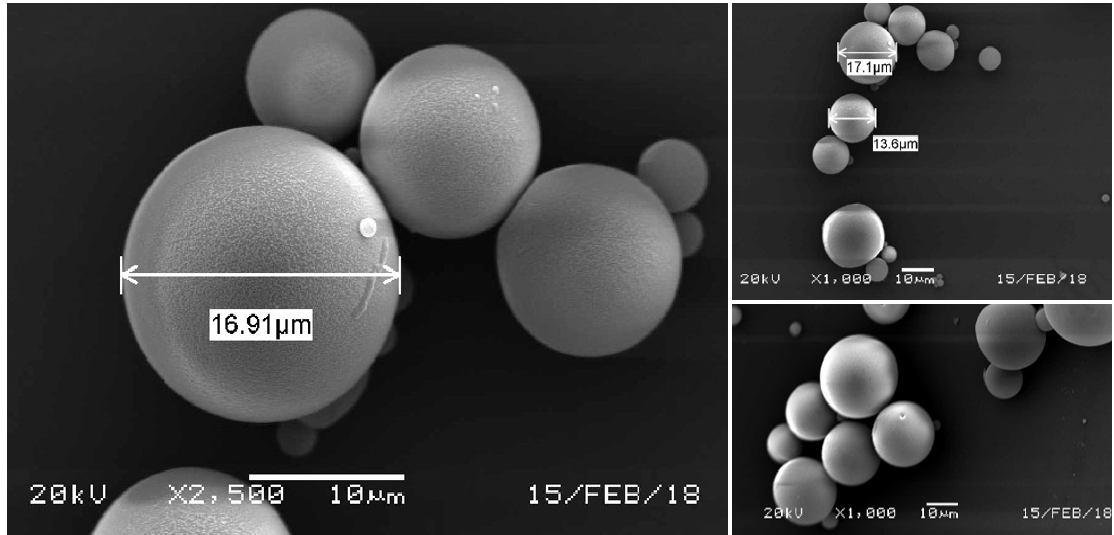
Figure 3. SEM images of the obtained polystyrene microcapsules (MCs).